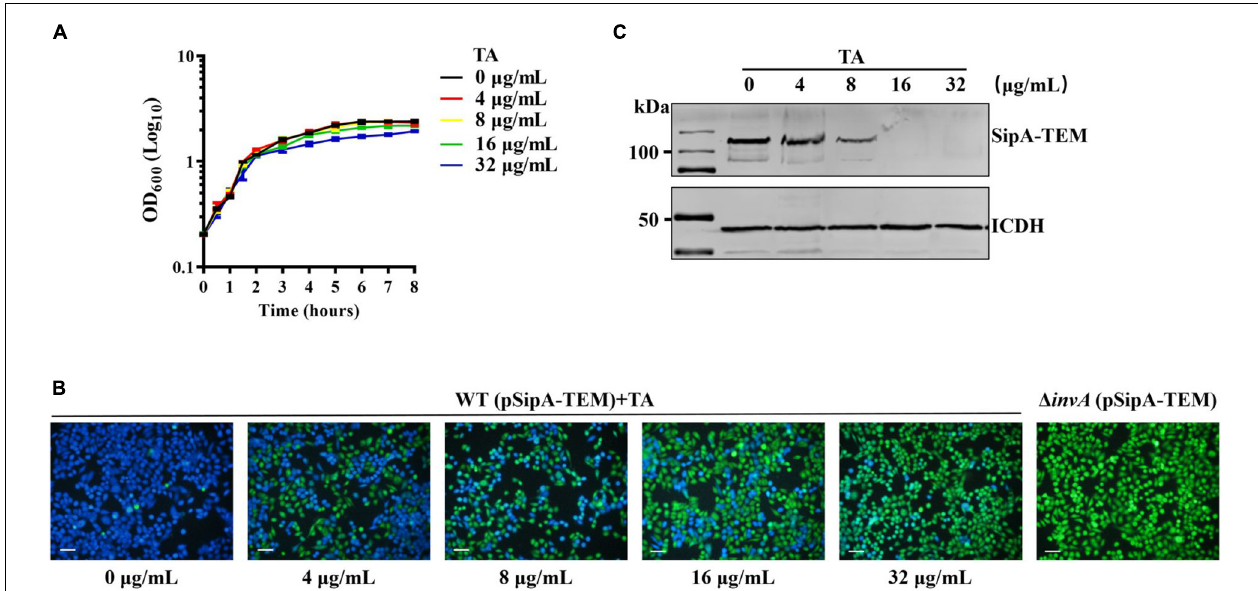
FIGURE 3 | Tannic acid inhibits translocation of SipA-TEM expressed in S. Typhimurium. (A) The effect of TA on S. Typhimurium growth. (B) The effect of TA treatment on the translocation of SipA-TEM expressed in S. Typhimurium into HeLa cells (Scale bar, 100 µ m). (C) The effect of TA treatment on the expression of SipA-TEM in S . Typhimurium.